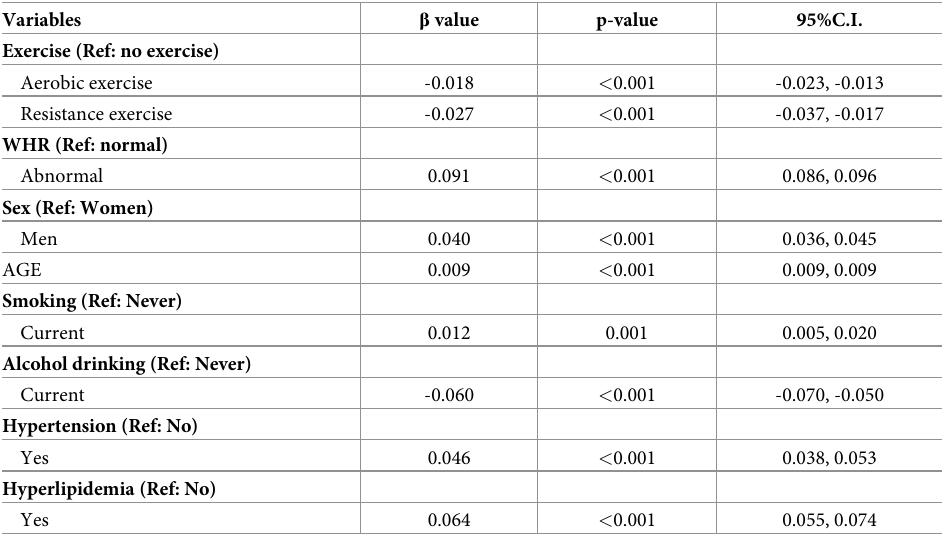
Table 2. Multiple linear regression showing effects of the study variables on HBA1c